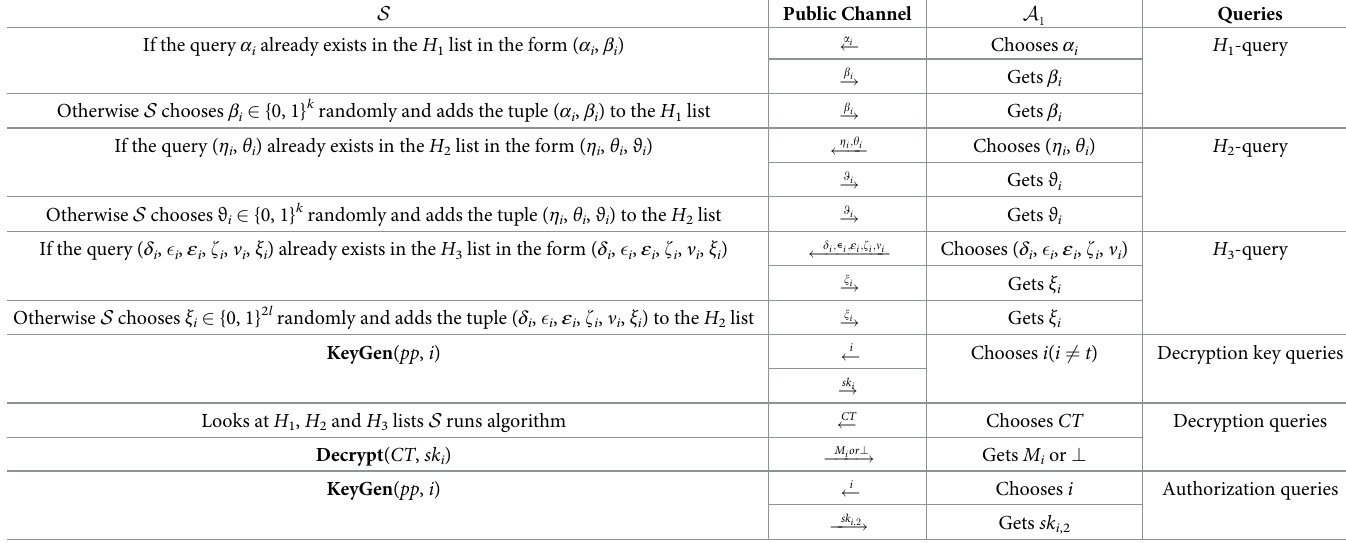
Table 5. Phase 1 of Game